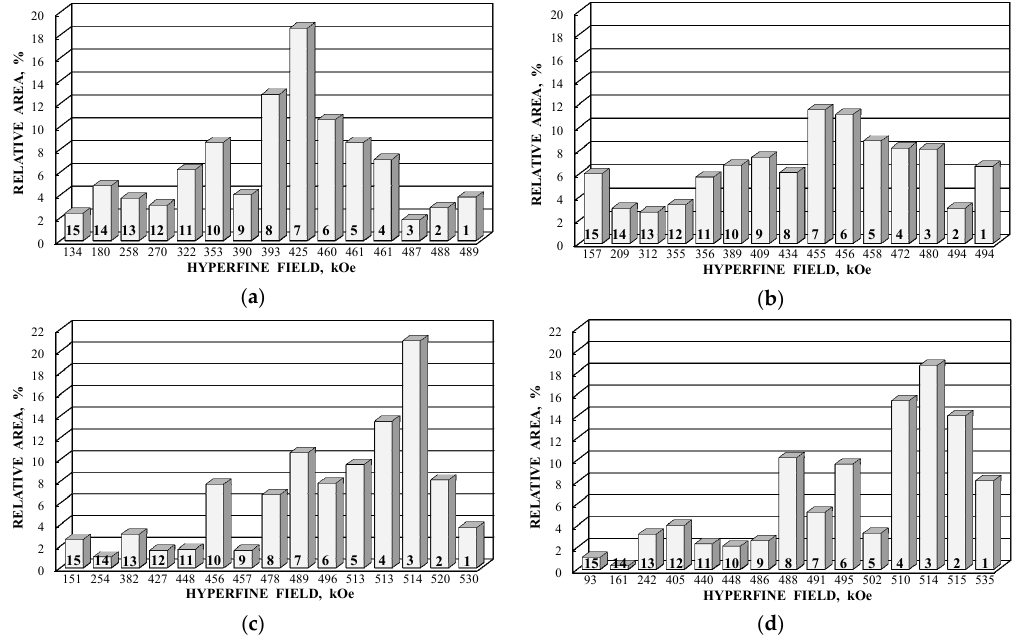
Figure 32. Histograms of the distributions of the relative areas of magnetic sextets in the order of H eff increase for corresponding spectral components of the as ‐ prepared Fe 3 O 4 nanoparticles ( a , c ) and those dispersed in Copaiba oil Fe 3 O 4 ‐ CO ( b , d ) at 295 K ( a , b ) and 90 K ( c , d ) (the numbers of sextets are the same as indicated in Figure 31). Adapted from Ref. [72] with permission from Elsevier: